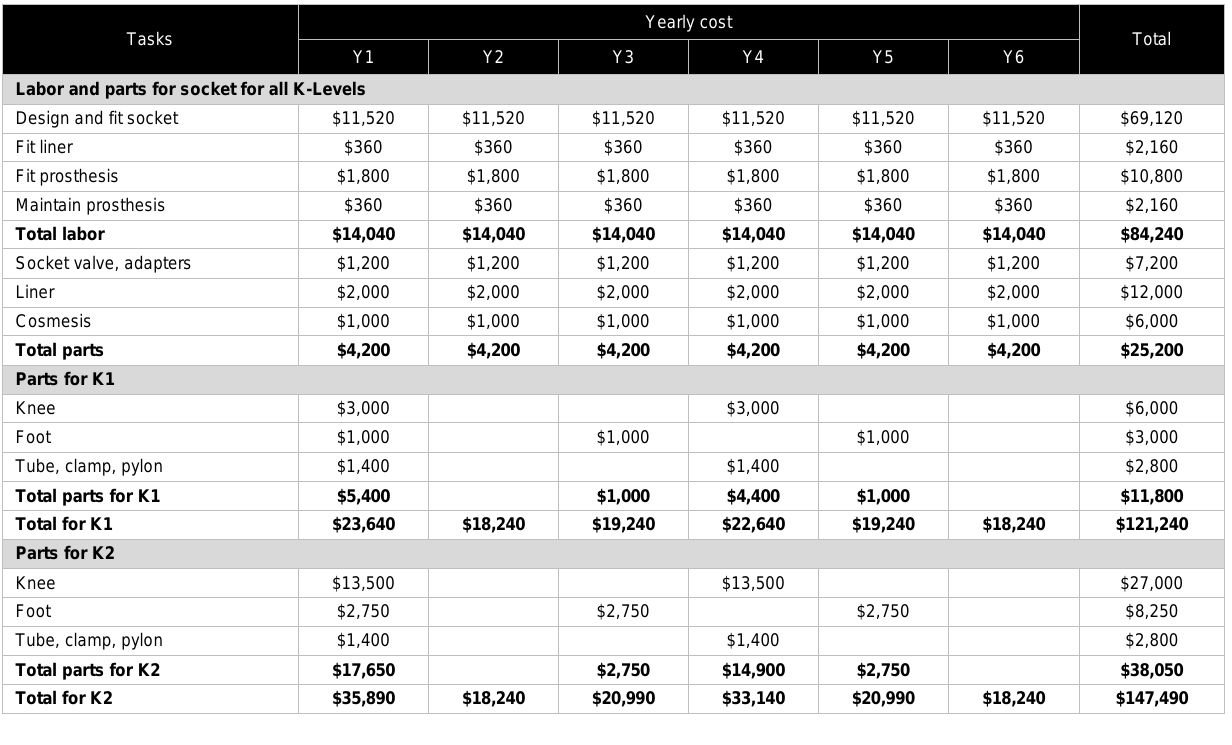
Table 2: Schedule of typical allowable expenses over six-year time horizon with yearly breakdown of labor and parts costs allocated for provision of transfemoral socket-suspended prostheses attached to residuum without distal weight bearing Keep Walking Implant for each K- Level (K1, K2). The number of units for all labor-related expenses corresponded to number of hours spent by a qualified prosthetist (e.g., CPO) at the standard Australian fixed hourly rate of